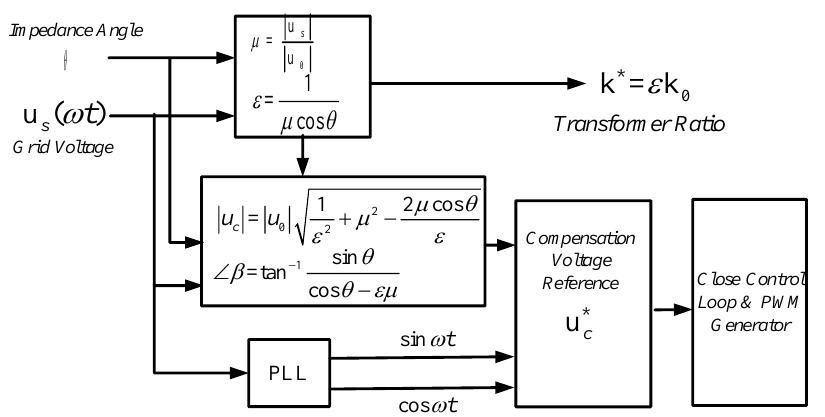
Figure 10. Block diagram of flexible OLVR complex control strategy.